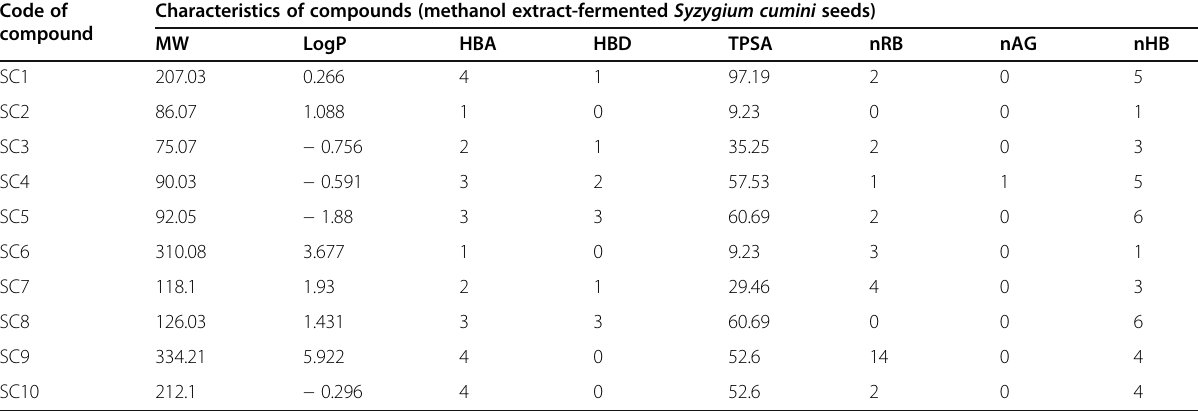
Table 3 Characteristics of compounds identified from GCMS analysis of fermented Syzygium cumini seeds methanol extracts Code of